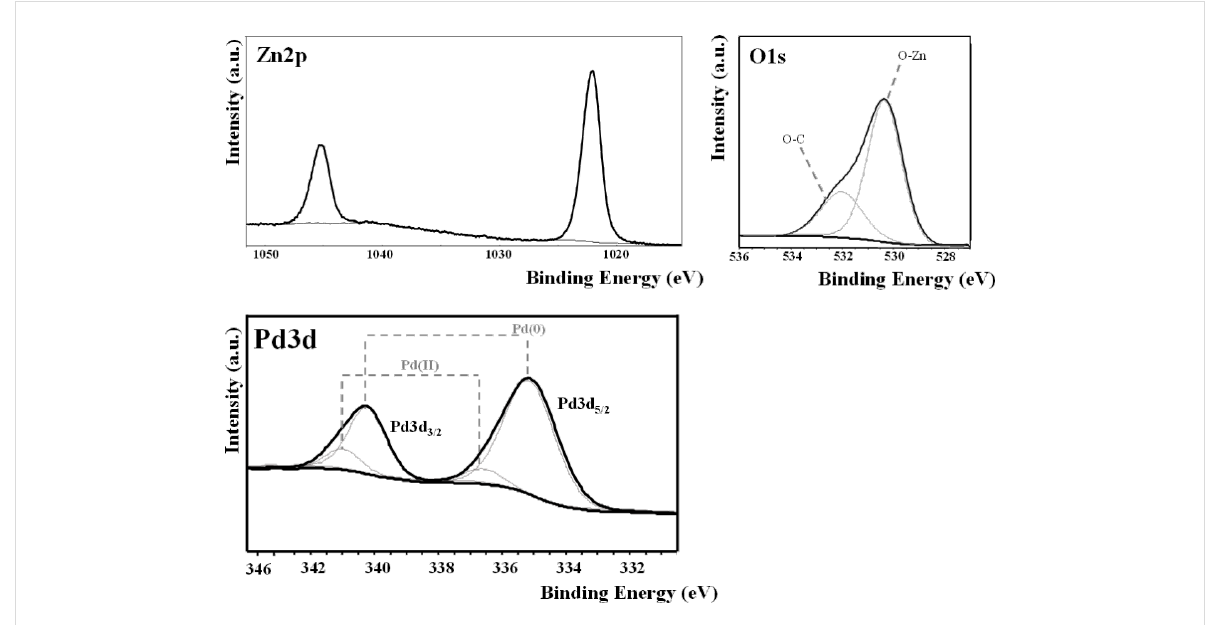
Figure 2: XPS spectra of the chemical elements in pristine ZnO: Zn 2p and O 1s spectra, deconvoluted in two components (O–Zn and O–C), with the additional Pd 3d spectrum in Pd@ZnO.